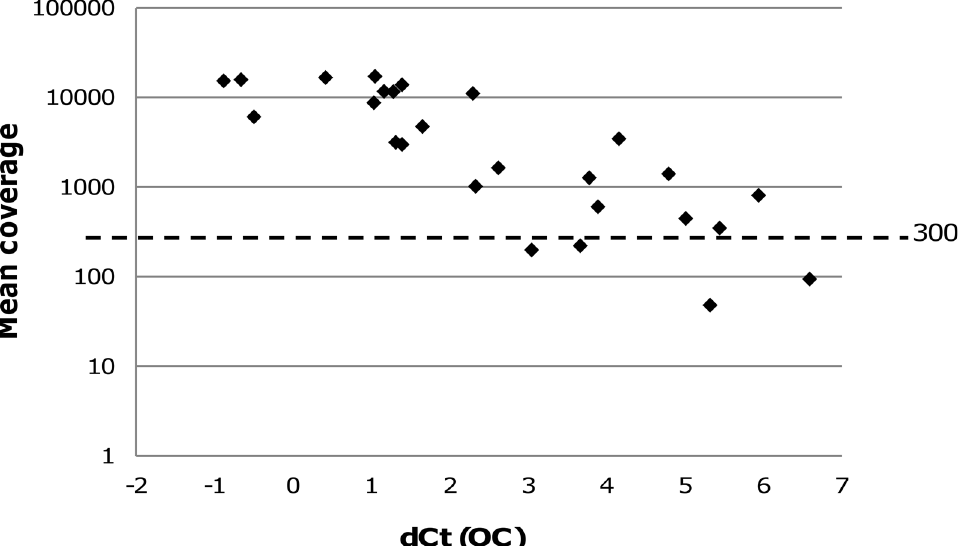
Fig 2. Correlation of dCt with mean coverage. Plot showing the correlation of the DNA quality (QC), expressed as dCt, with the mean coverage (log scale) of 26 random FFPE validation